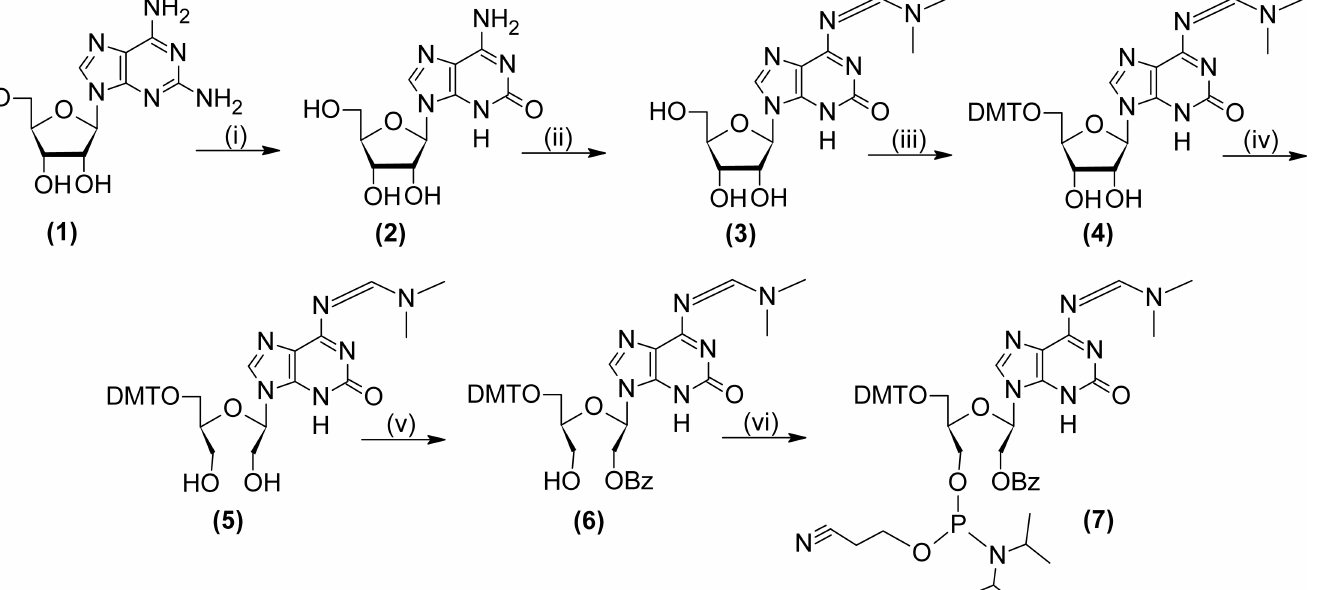
PLOS ONE | https://doi.org/10.1371/journal.pone.0197835 May 24,